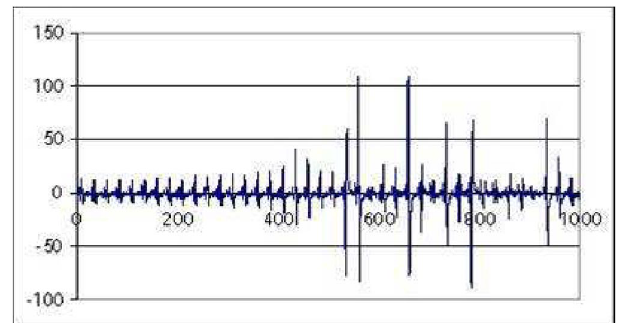
FIG. 22. (Color) Snapshot of vertical position of the first 48 bunches in the SPS when the instability is present